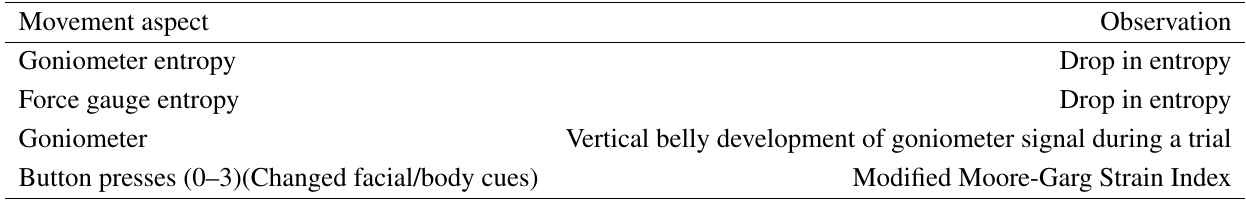
Table 1. Labelling criteria for the movement aspects.